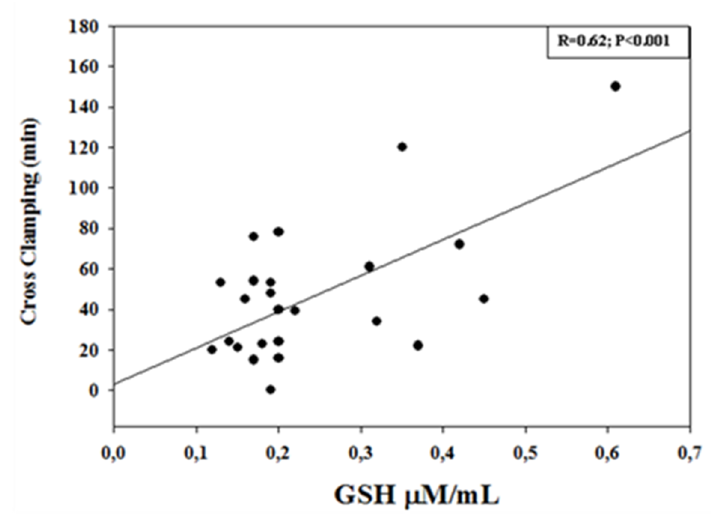
Figure 4. Correlation between GSH concentrations ( µ M / mL) measured at the end of cardiopulmonary bypass (CPB) procedure and cross-clamping duration (min). There was a significant positive correlation (R = 0.62; p < 0.001).